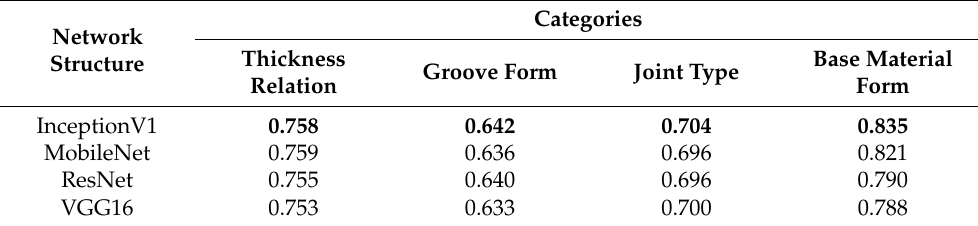
Table 4. Comparison results of different CNN